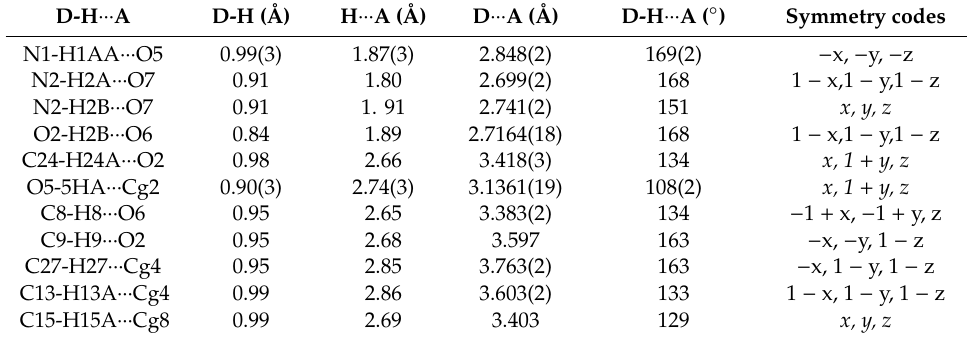
Table 2. Geometrical parameters of the hydrogen bond interaction in salt